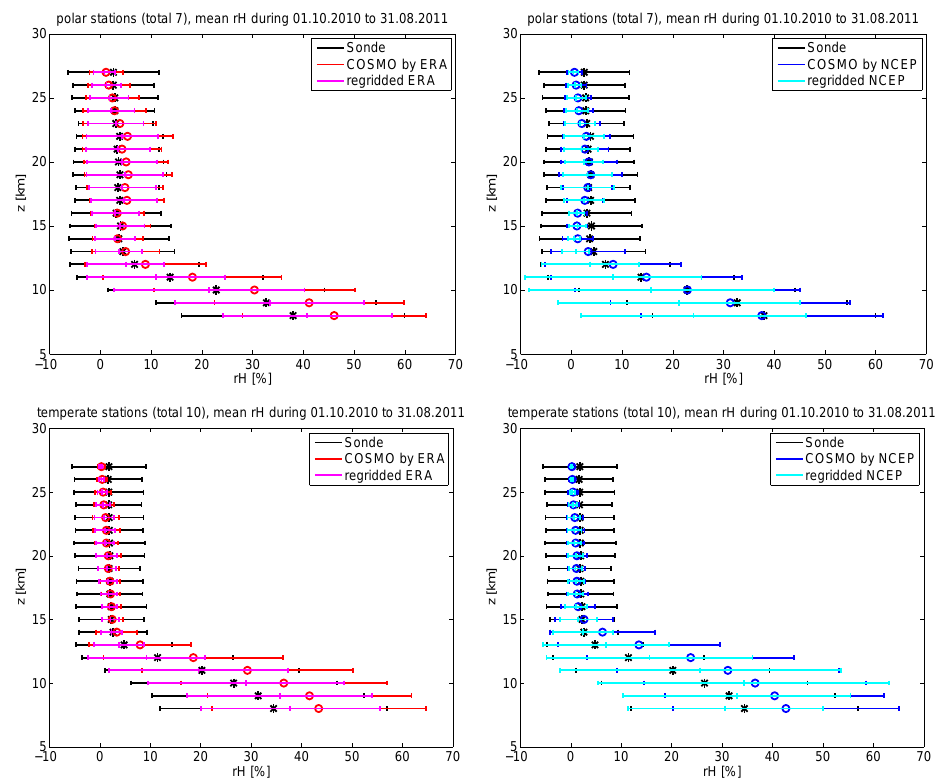
Figure 12. Mean values of relative humidity for polar (top) and temperate (bottom) stations for the model run forced by ERA-Interim (left) an NCEP (right) reanalysis data. Russian stations were excluded from this analysis, as described in the text. The horizontal lines give the 1 σ standard